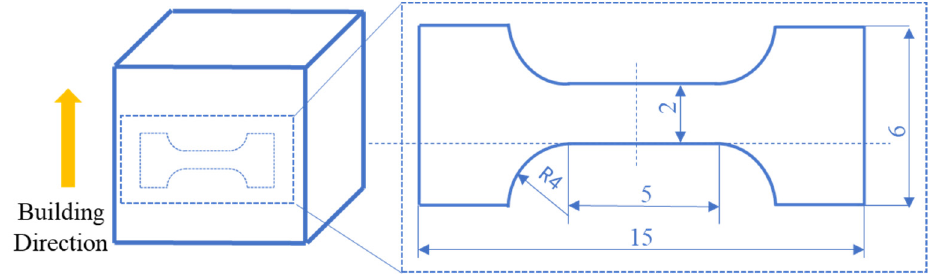
Figure 2. The cutting position with the shape and size of the tensile specimen for mechanical tests (dimensions of the sample given in mm).